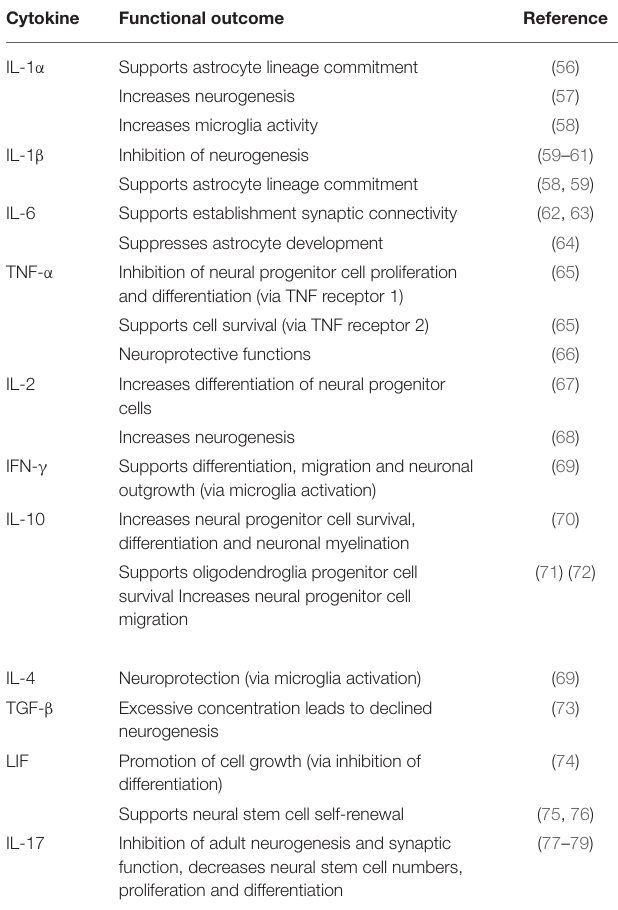
TABLE 3 | Key cytokines influencing neural cell